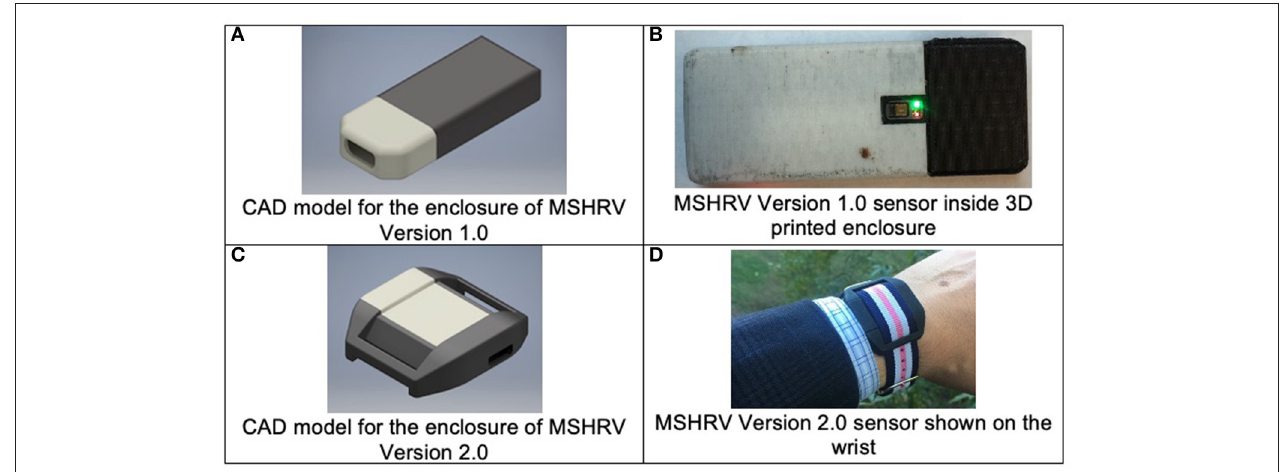
FIGURE 1 | Wrist-worn sensor development. (A,B) Illustrate the version of the wrist-worn sensor used in the Phase 1 Pilot study. (C,D) Show the sensor used in the Phase 2 Main